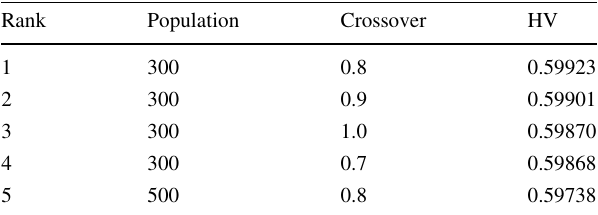
Table 5 MA: ranking of best 5 combinations based on HV mean values